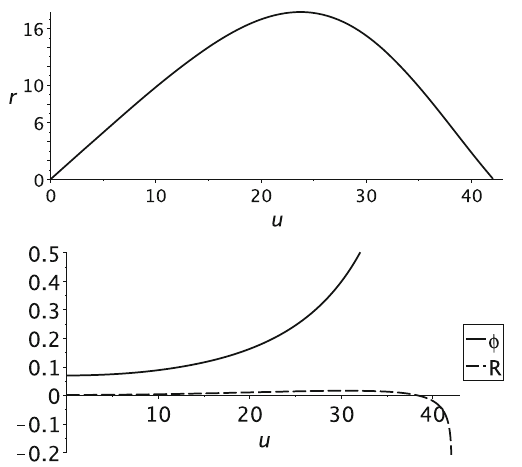
Fig. 5 The parameter values: m = 0 . 1 , b = 1 , a = 10 , c = 0 . 0021. Additional conditions: φ 0 = 0 . 07 , H = 0 , R ( 0 ) (cid:10) 0 . 00189 follows from Eq.(23)